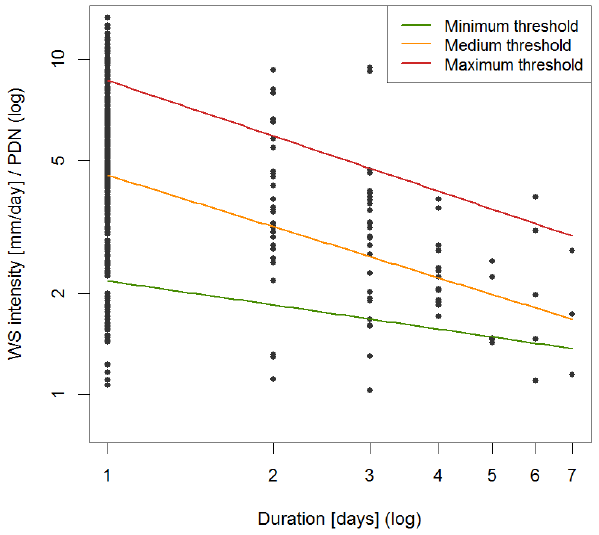
Fig. 5. Normalized ID threshold curves for debris flow initiation. Water supply (WS) intensities were normalized with the precipita- tion day normal (PDN). The curves were obtained from the 3-day moving average of the 5th and 15th percentiles (minimum thresh- old), the 45th and 55th percentiles (medium threshold) and the 85th and 95th percentiles (maximum threshold) ( n = 502).